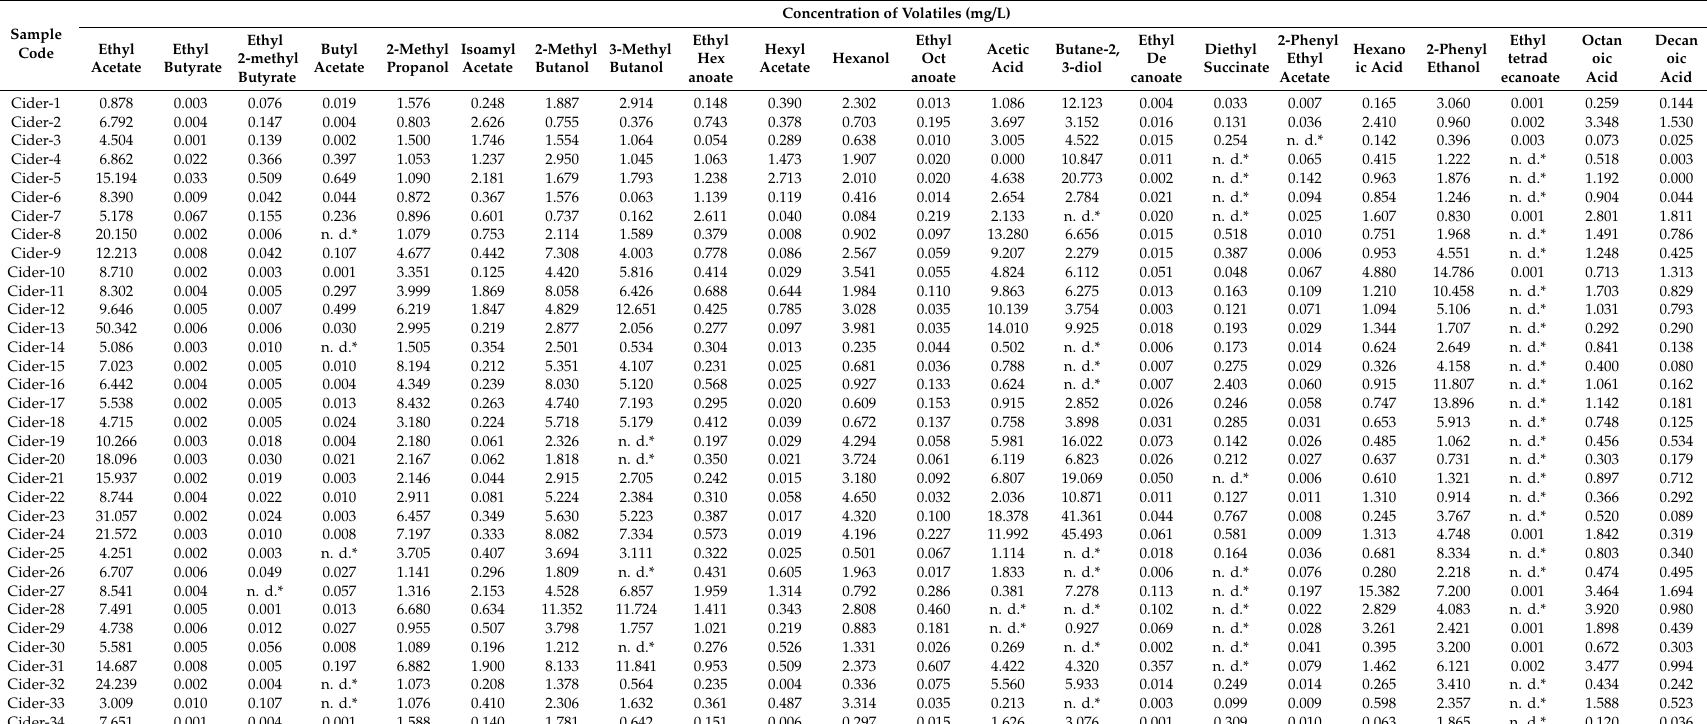
Table 1. Concentrations of volatile compounds in the European ciders